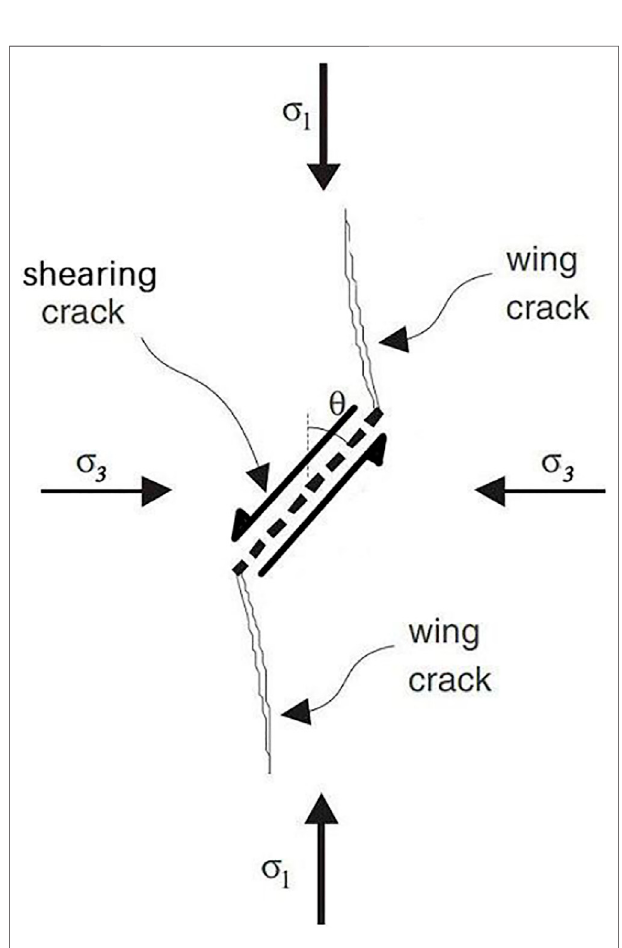
FIGURE 2 | Schematic diagram of the sliding crack model (Yuan S. C., 2006).